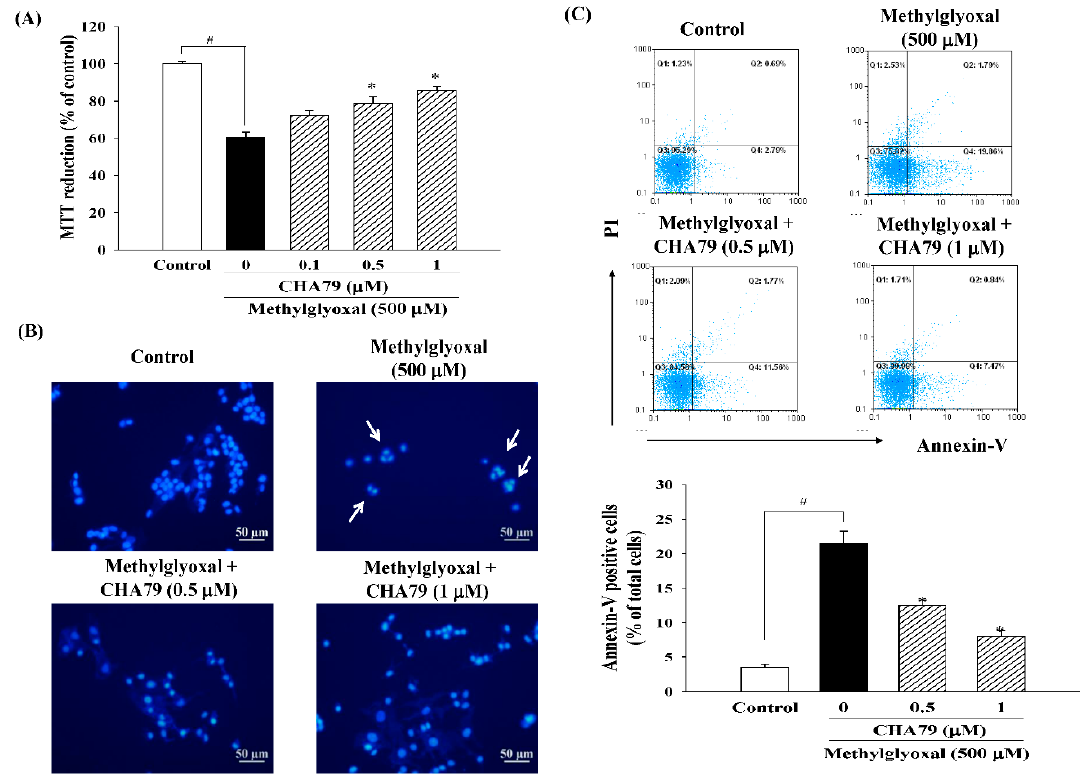
Figure 2. Effects of CHA79 on cell viability ( A ), nuclear condensation ( B ), and Annexin V-positive cell numbers ( C ) in MG-treated SH-SY5Y dopaminergic neurons. Cells were pre-treated with CHA79 (0.1–1 μ M) for 1 h, and MG (500 μ M) was then treated for 24 h. Cell viability was determined by MTT assay. Nuclear condensation (white arrow) was determined by Hoechst 33342 and observed by a fluorescent microscope. Scale bar = 50 μ M. Annexin V-positive cell numbers were counted by flow cytometer and were represented as the percentage of total cell numbers. # p < 0.05 versus the control group (vehicle control: 0.1% DMSO). * p < 0.05 versus the MG group.